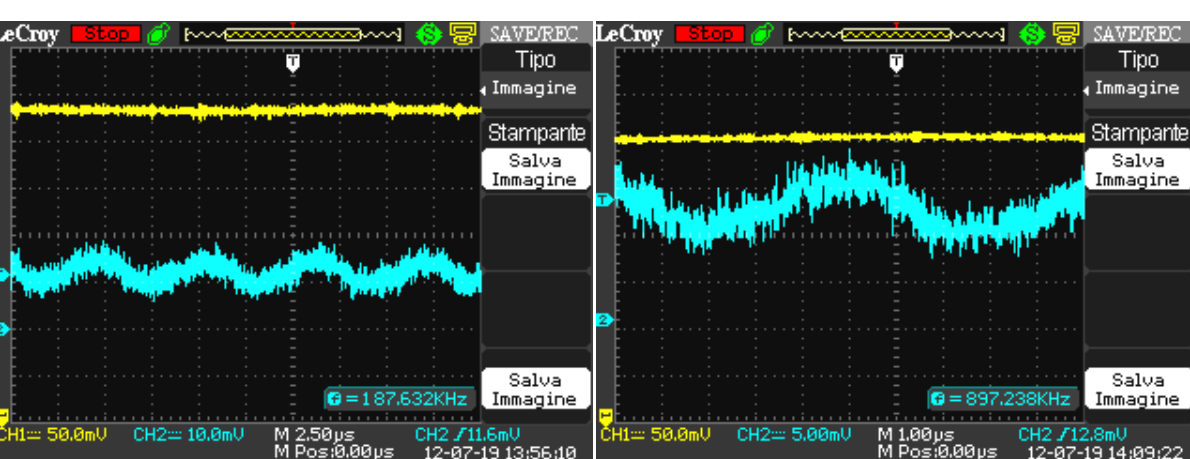
Figure 18. ( a ) DC to ground voltage oscillation (cyan trace) and DC current (yellow trace); ( b ) Particular of the DC voltage ripple.